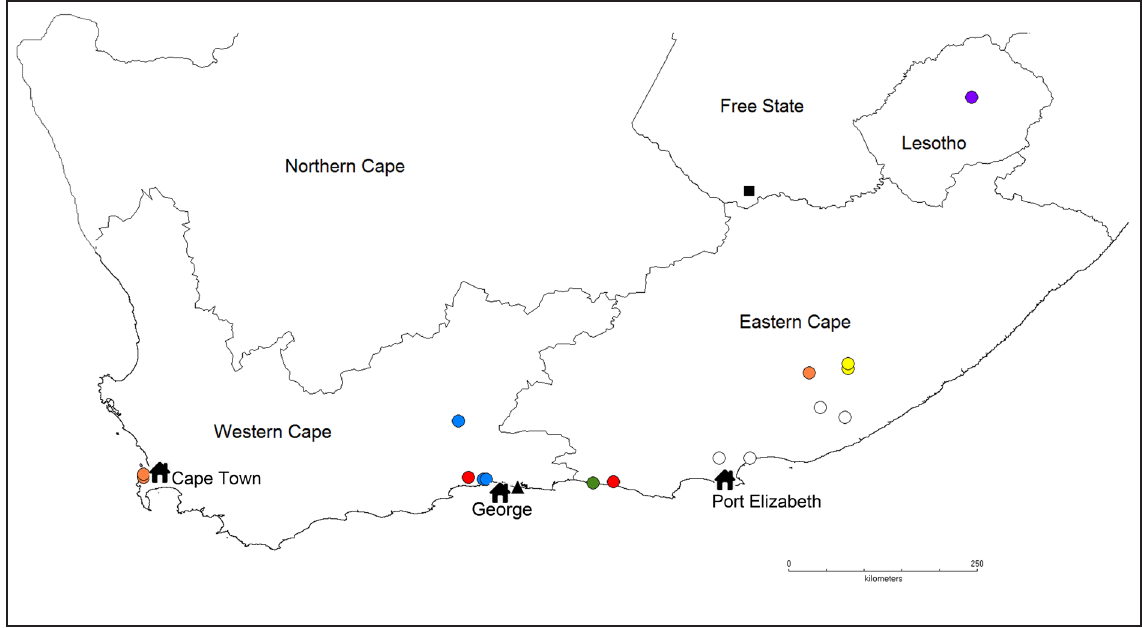
Fig. 12. Distribution map of Chumma spp.: C. bicolor sp. nov. ( ▲); C. foliata sp. nov. (●); C. gastroperforata Jocqué, 2001 (●); C. inquieta Jocqué, 2001 (○); C. interfluvialis sp. nov. (■); C. lesotho sp. nov. (●); C. striata sp. nov. (●); C. subridens sp. nov. (●); C. tsitsikamma sp. nov.